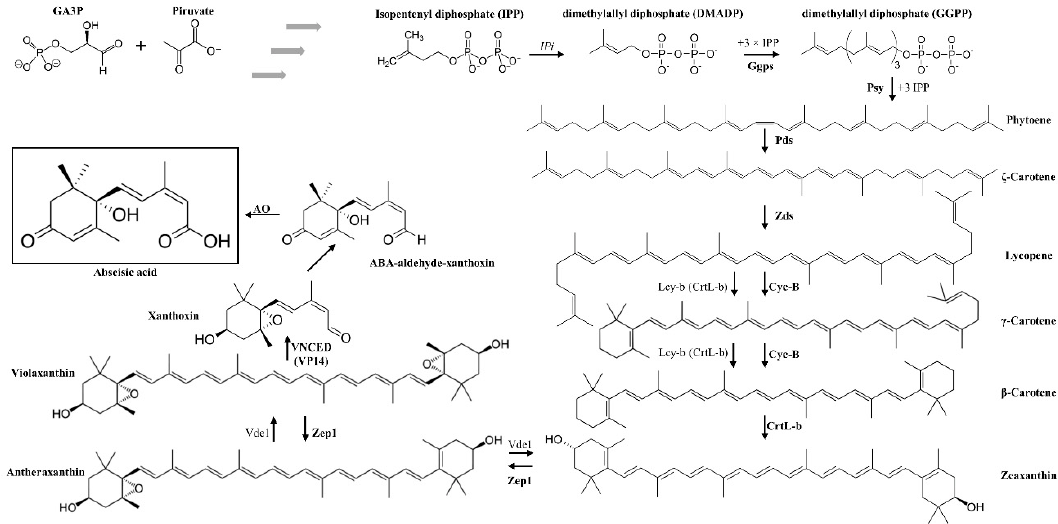
Figure 1. Abscisic acid (ABA) biosynthesis pathway in plants: Ggps: Geranylgeranyl pyrophosphate